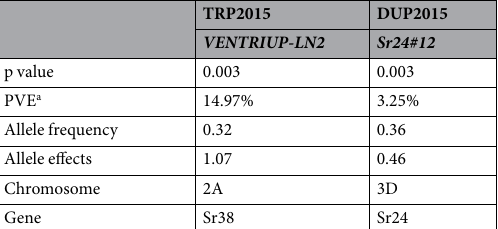
Table 1. Single marker analysis for stem rust resistance in the DUP2015 and TRP2015 nurseries. a Phenotypic variation explained by marker.